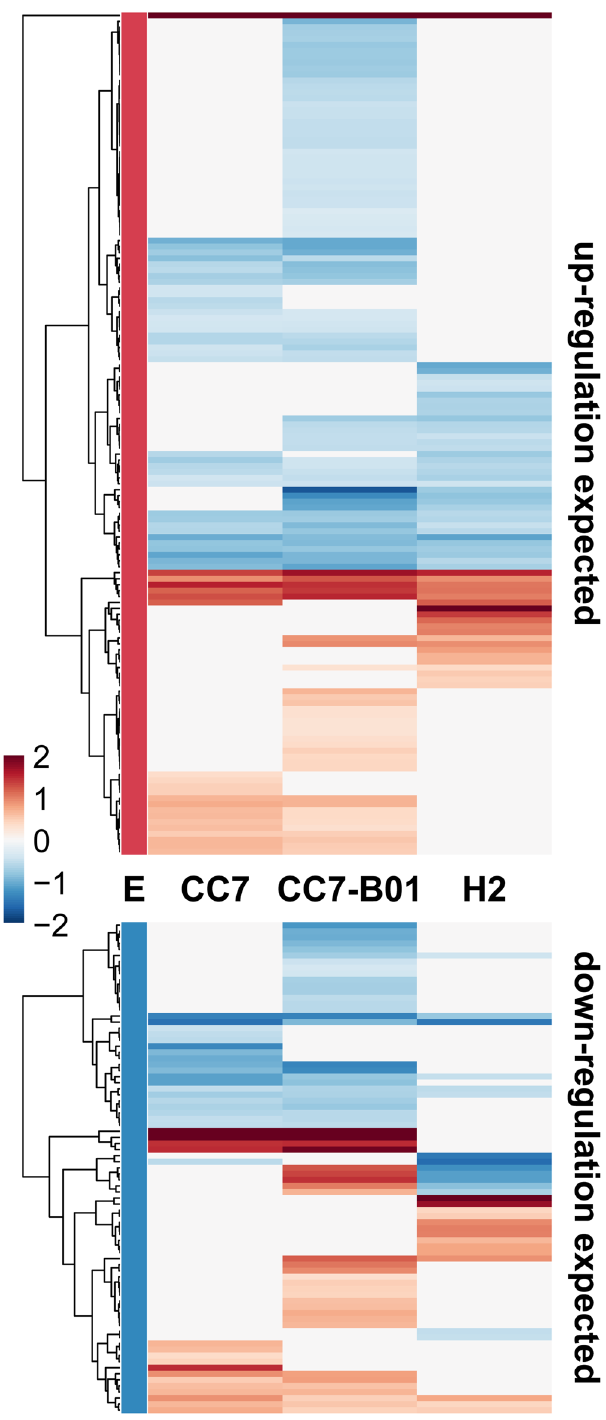
Fig. 4 Heat map indicating expression changes of symbiosis-associated genes in response to heat stress. The three strains are labelled accordingly. The column labelled as ‘ E ’ represents the expected gene expression changes in known symbiosis-associated genes from Cui et al., 2019. Genes in E are coloured by expected responses to symbiosis: up- regulation (top half of the fi gure; red E) or down-regulation (bottom half; blue E) during symbiosis relative to aposymbiotic state. Other columns indicate observed responses in each of the three studied strains. Coloured columns indicate signi fi cant differential expression ( n = 4; p < 0.05; red is up-regulated, blue down-regulated); clear columns indicate no signi fi cant change. Values of colour scale are log 2 -transformed fold changes